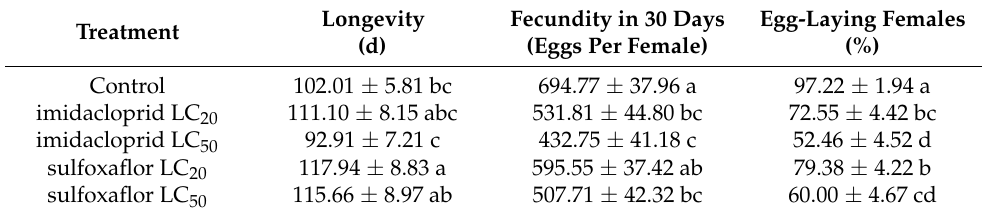
Table 3. Mean ( ± SE) values of longevity and fecundity of Harmonia axyridis females exposed to imidacloprid and sulfoxaflor and their LC 50 and LC 20 estimated for the target pest, Aphis gossypii . Values followed by different letters, within the same column, indicate significant differences at p < 0.05